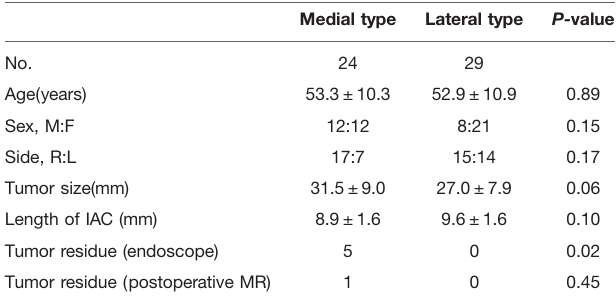
TABLE 2 | Patient characteristics between the two types.